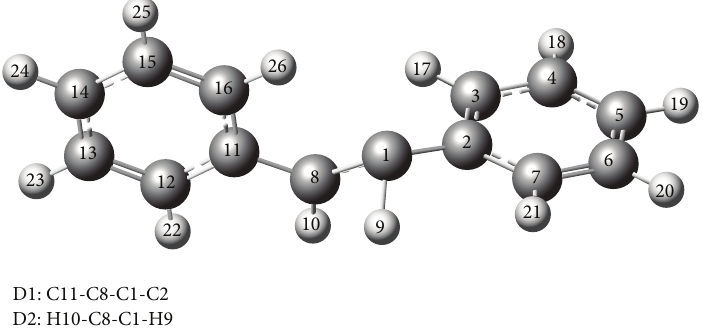
Figure 1: Atom numbering of Stilbene at the 𝑆 1 /𝑆 0 conical intersection (OBF-CI) configuration in terms of two dihedral angles D1 and D2 at which D10 = − 146.6 ∘ and D20 = − 60.0 ∘